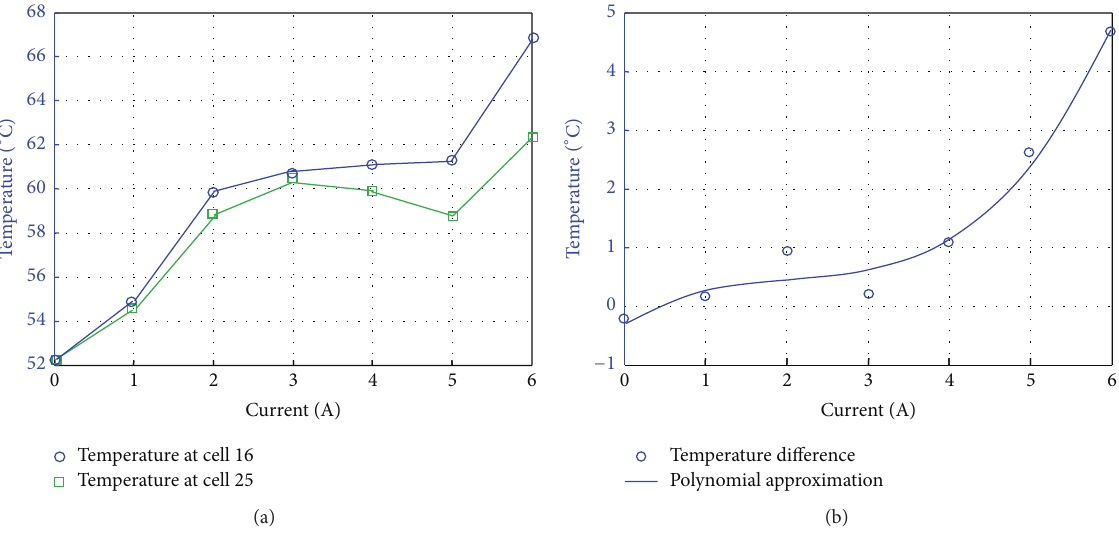
Figure 8: Current characterization under 1 A increments: (a) temperature graph and (b) temperature